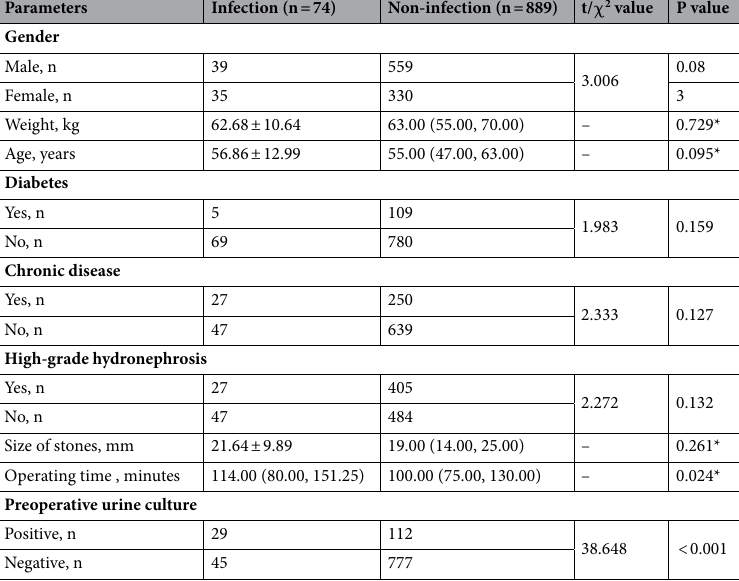
Table 1. General information and univariate analysis results of preoperative risk factors about the patients. *The result was obtained using the rank-sum test.